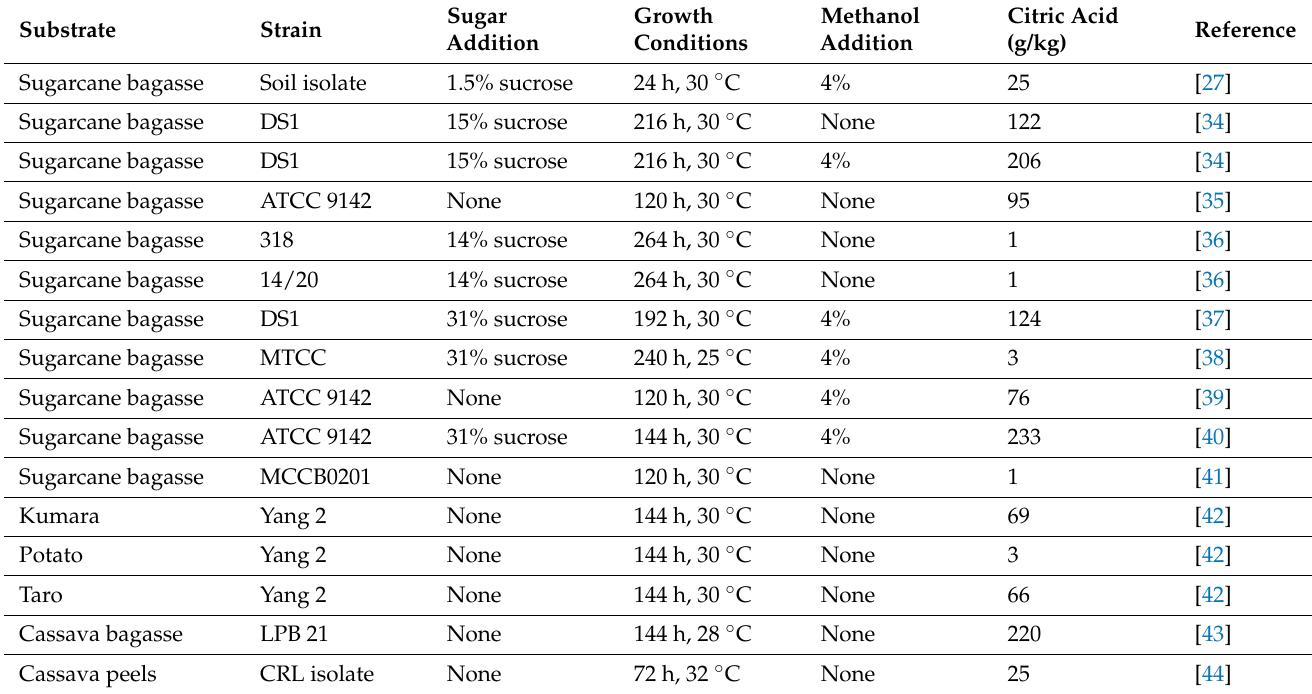
Table 3. Growth conditions and maximum citric acid production by Aspergillus niger strains on sugarcane bagasse and starchy vegetable processing wastes using solid-state